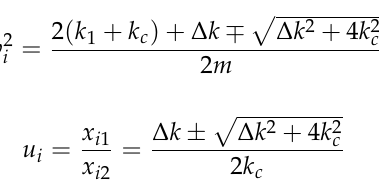
of the two vibrating modes can be derived as [34]